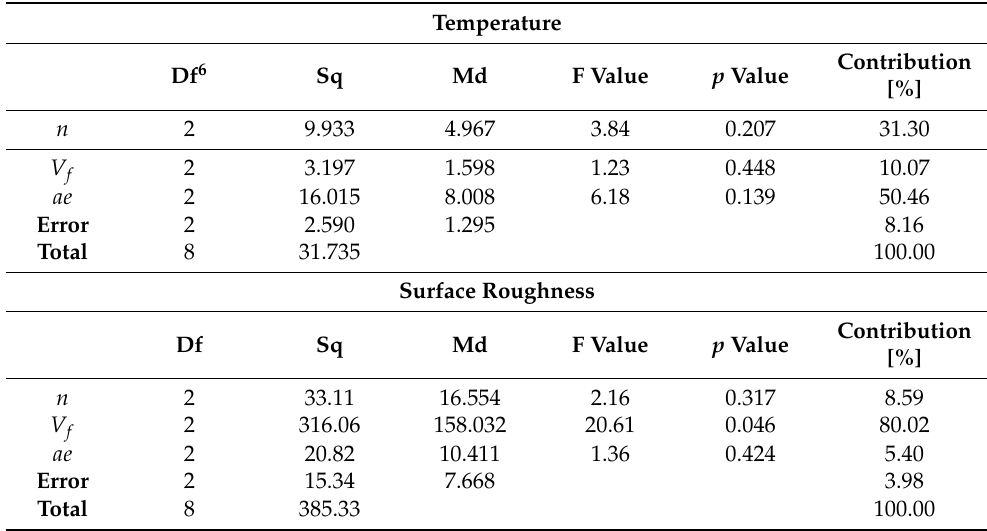
Table 14. ANOVA analysis for chip temperatures and surface roughness of the workpiece after machining tests with vegetable oil (50